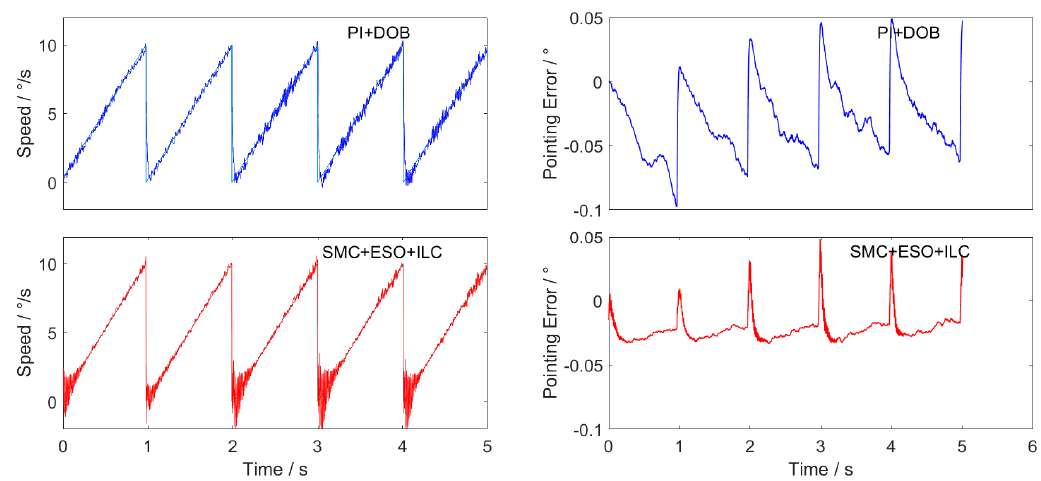
Figure 14. Triangular wave tracking curve and position pointing error.